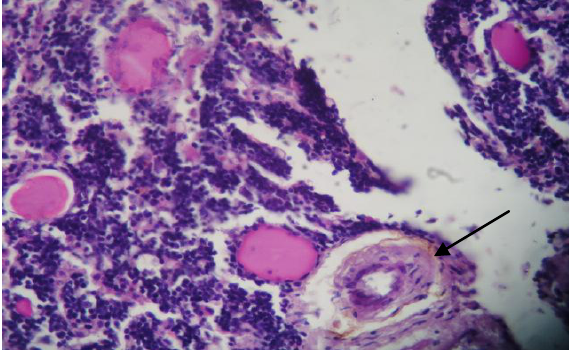
Figure, 2: Kidney in fish small and large thyroid follicles filled with homogenous colloid. Notice the large arteriole near one follicle (arrow) (40X. PAS stain)